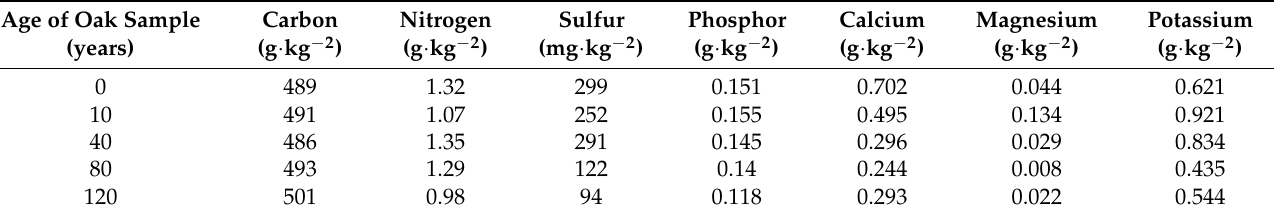
Table 3. Elementary analysis of oak